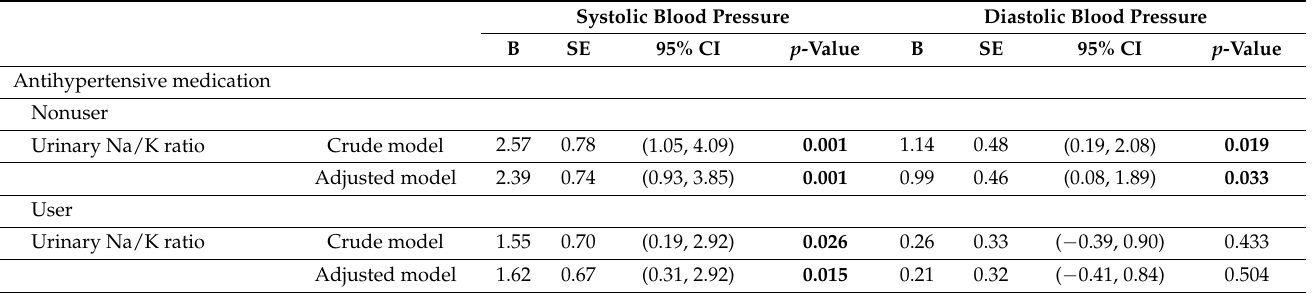
Table 3. Subgroup analyses of the association between changes in the urinary Na/K ratio and blood pressure using antihypertensive